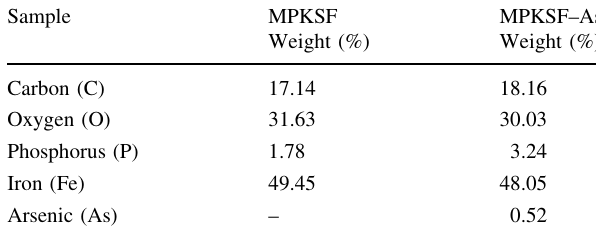
Table 10 Elemental analysis for sample MPKSF and MPKSF–As